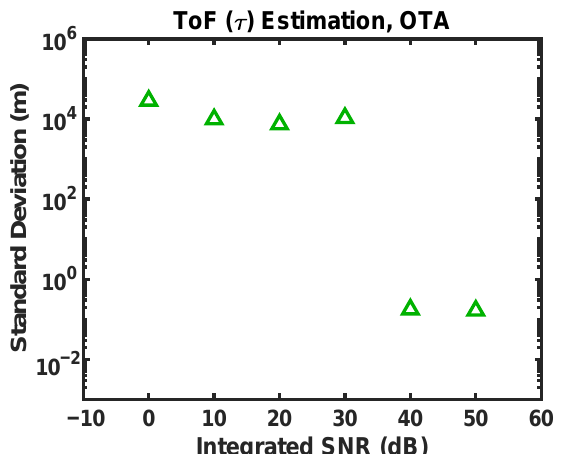
Figure 21. Over-the-air time-of-arrival estimation standard deviation, plotted against the CRLB and fundamental resolution.